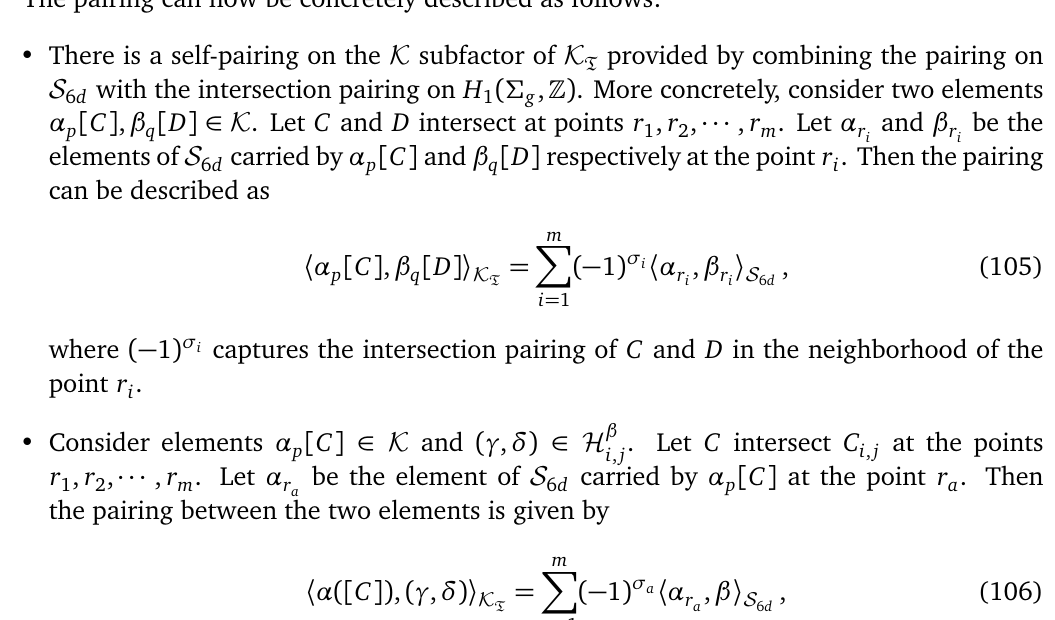
. As one traverses the loop counter-clockwise starting from g carried by C at point p is specified, the element 6 d is fixed to be o i , i + 1